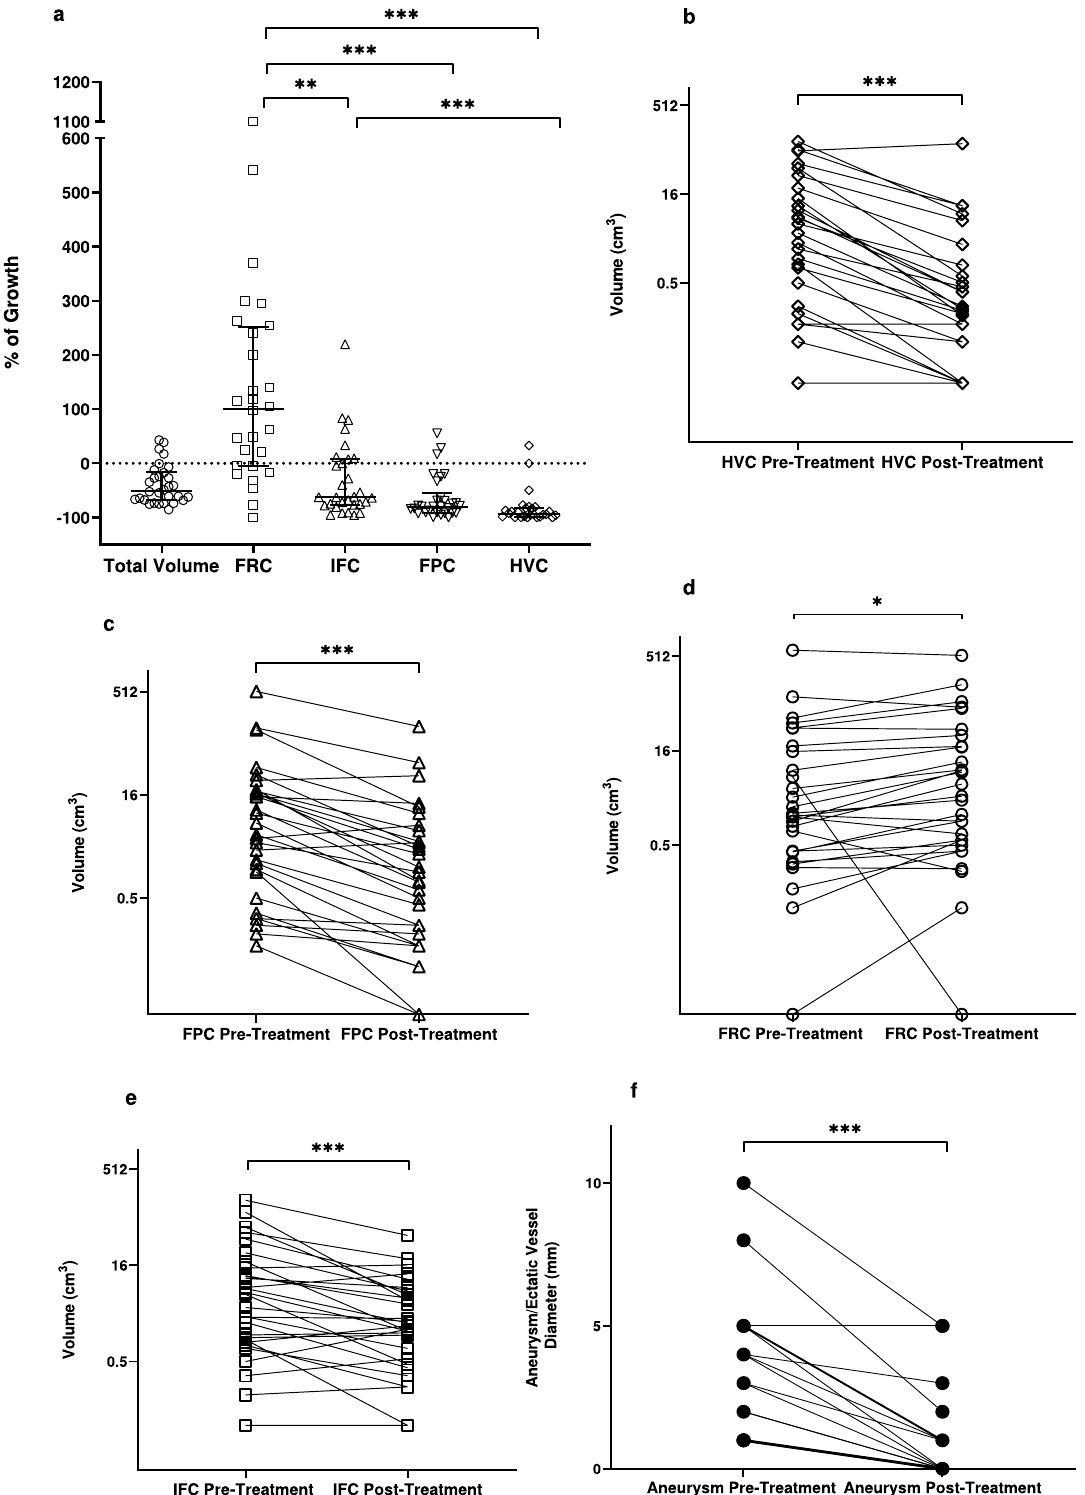
Figure 3. Percent variation of total tumor volume and volumes of tumor compartments following treatment with sirolimus ( a ). Variation of tumor compartment volumes—HVC ( b ), FPC ( c ), FRC ( d ) and IFC ( e )— following treatment with sirolimus; and diameter variation of intra-tumoral ectatic vessels/aneurysms ( f ) in response to sirolimus. HVC, FPC and IFC presented significant volume reduction while FRC displayed volume increase. Comparisons between different groups were performed with Kruskal–Wallis test and repeated measures were analyzed with the Wilcoxon test. FPC fat-poor compartment, FRC fat-rich compartment, HVC highly-vascularized compartment, IFC intermediate-fat compartment. *P < 0.05, **P < 0.01, ***P <